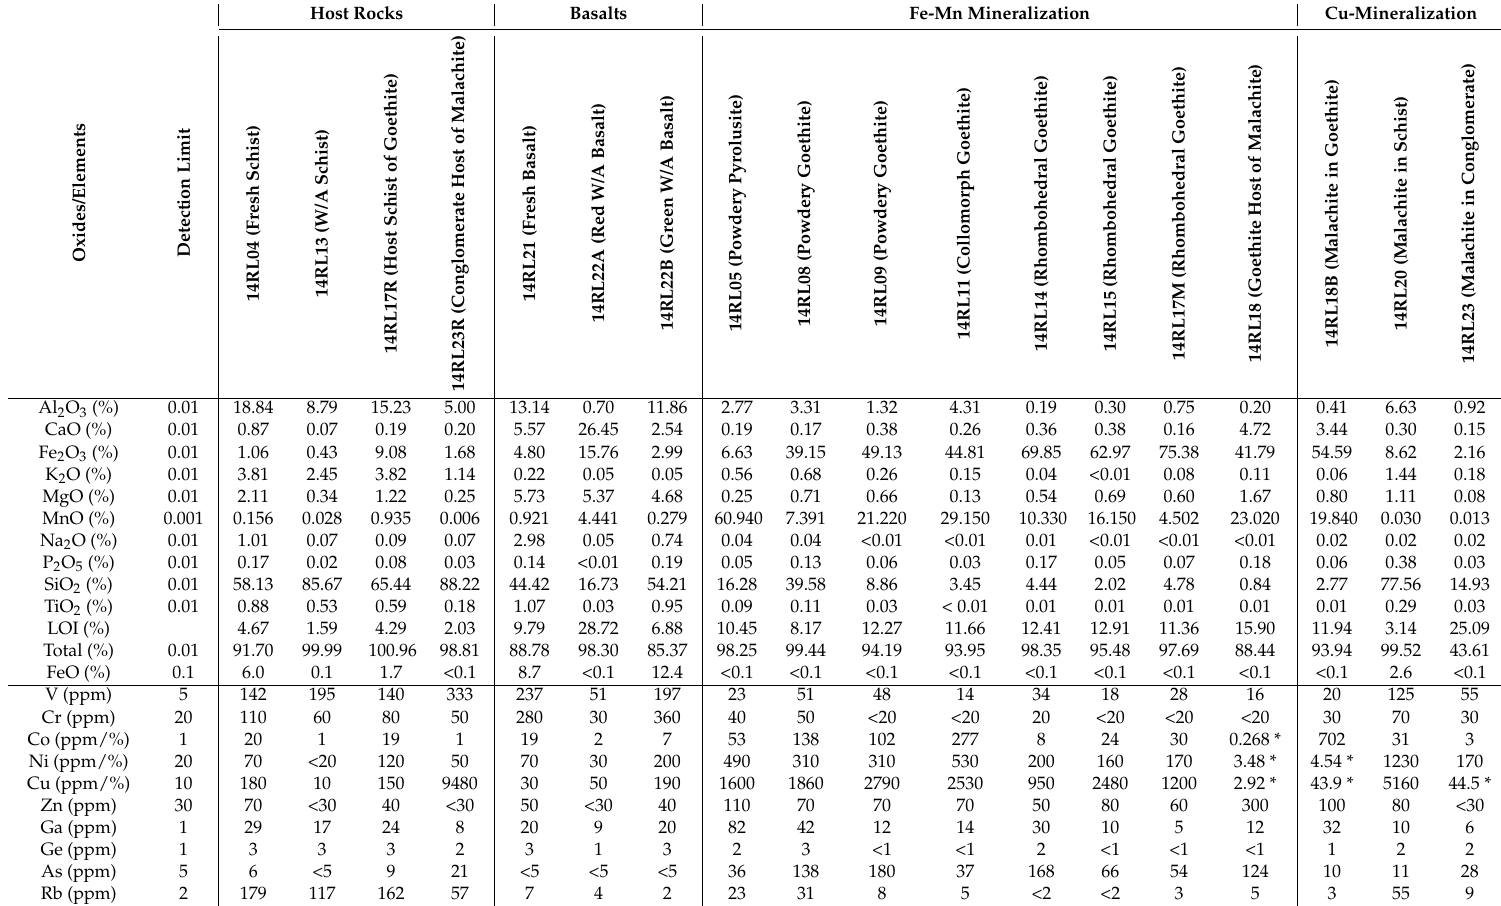
Table 1. Results of geochemical analyses for selected samples of host rocks and mineralized samples (W/A = weathered and/or altered). Major elements concentrations are listed in %, minor elements and Rare Earth Elements (REE) are given in ppm. For minor elements, values in bold and marked with an asterisk (*) correspond to contents in %: the detection limit is fixed at 0.01% for Ni and Cu, and 0.001% for Co and Mo. The Eu and Ce anomalies (Eu/Eu* and Ce/Ce*) are calculated with PAAS (Post Archean Australian Shale)-normalized values